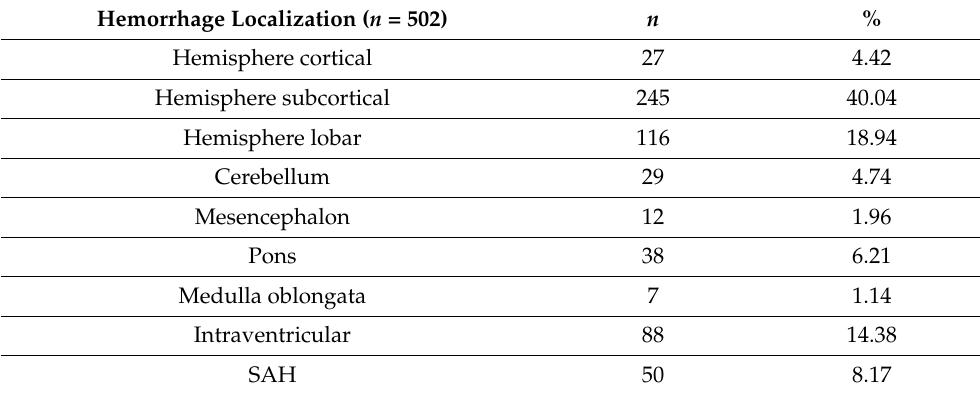
Table 3. Frequency of cerebral hemorrhage subtypes according to hemorrhage